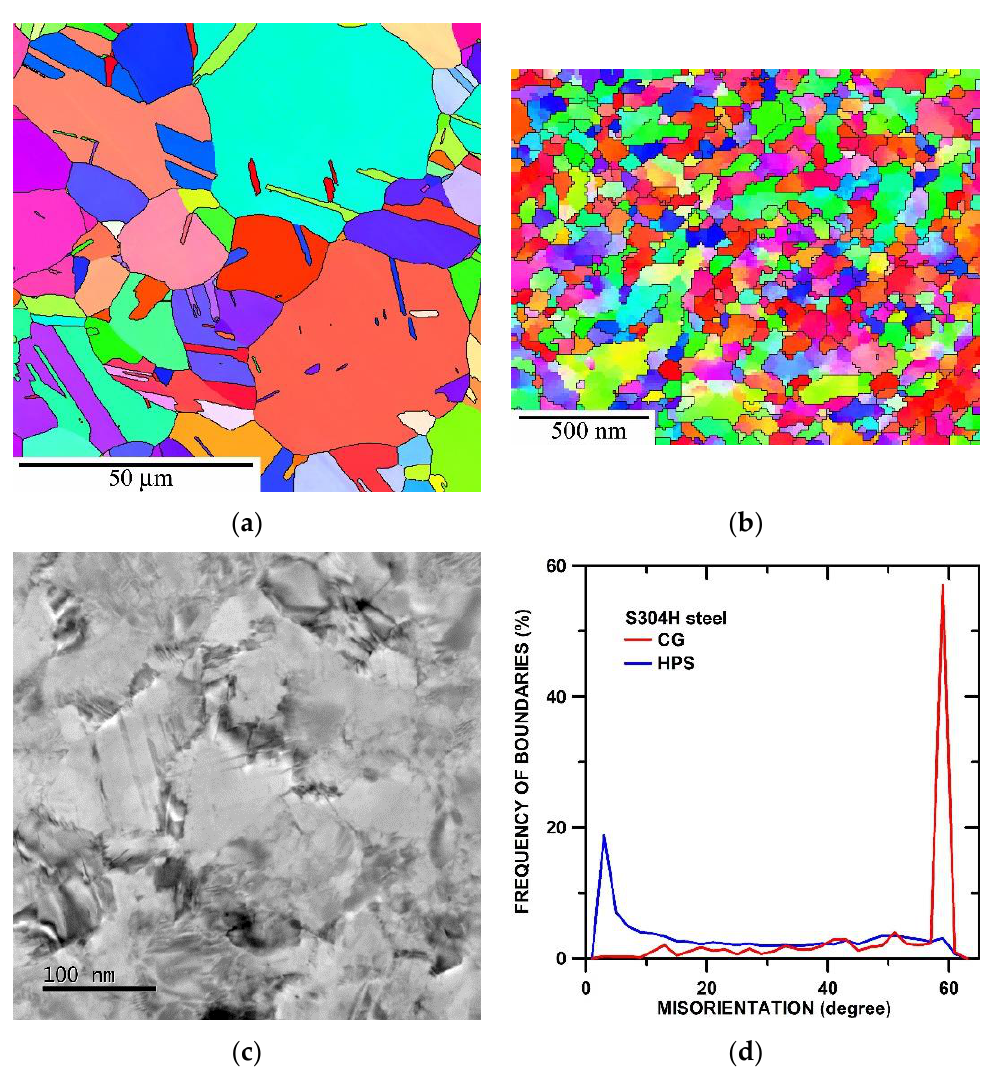
Figure 3. Microstructure of S304H steel before creep testing ( a ) inverse pole figure (IPF) for CG state, ( b ) IPF for HPS-processed state, ( c ) TEM micrograph of HPS-processed state and ( d ) misorientation distributions for CG and HPS-processed state.